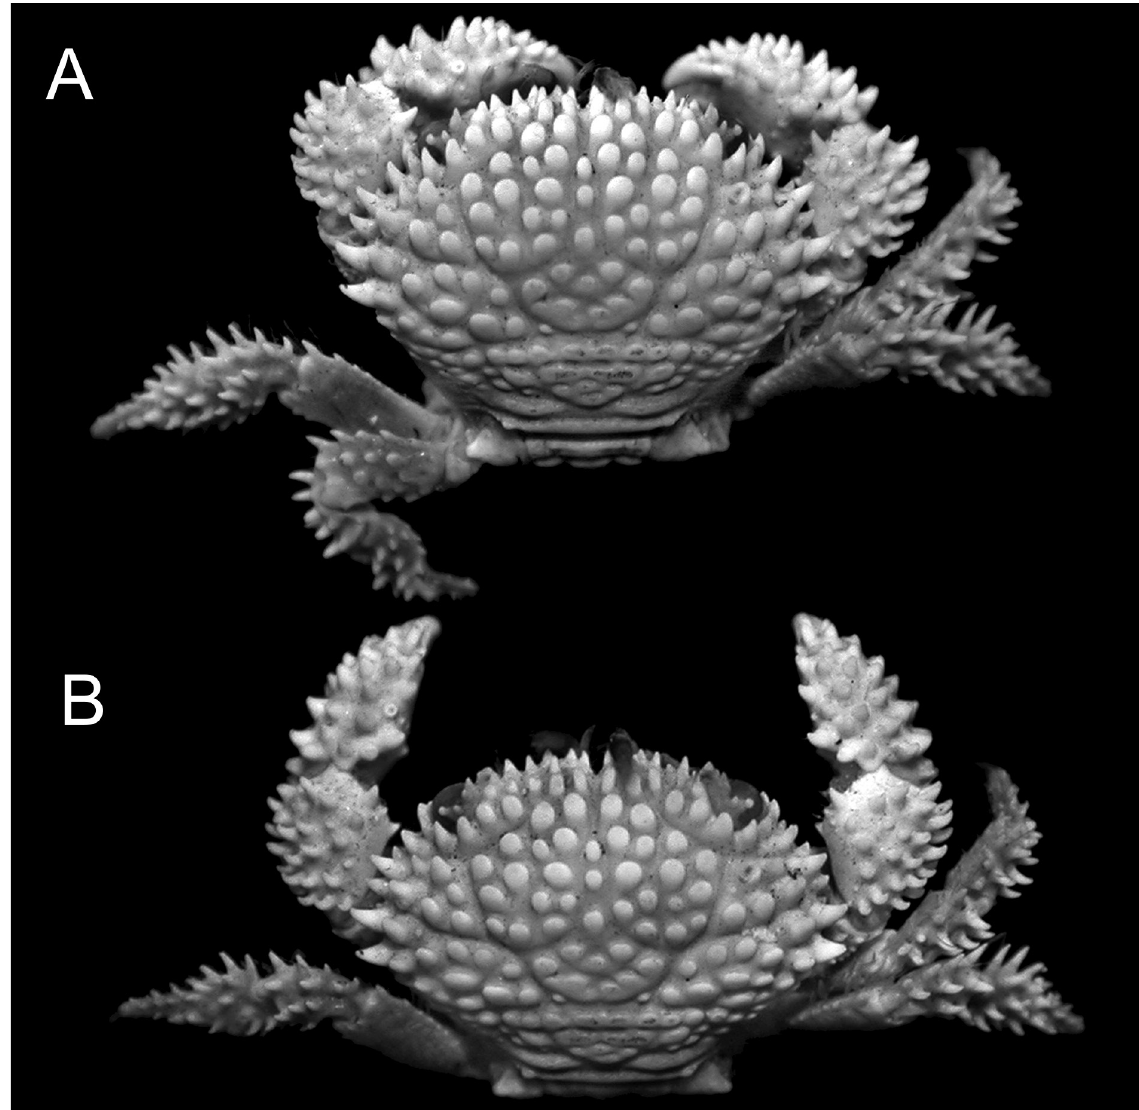
Fig. 6. Actaea spinosissima Borradaile, 1902, holotype, ♂, 5.1 × 3.4 mm (CUMZ I.63106). Dorsal view of habitus, photographed from slightly different